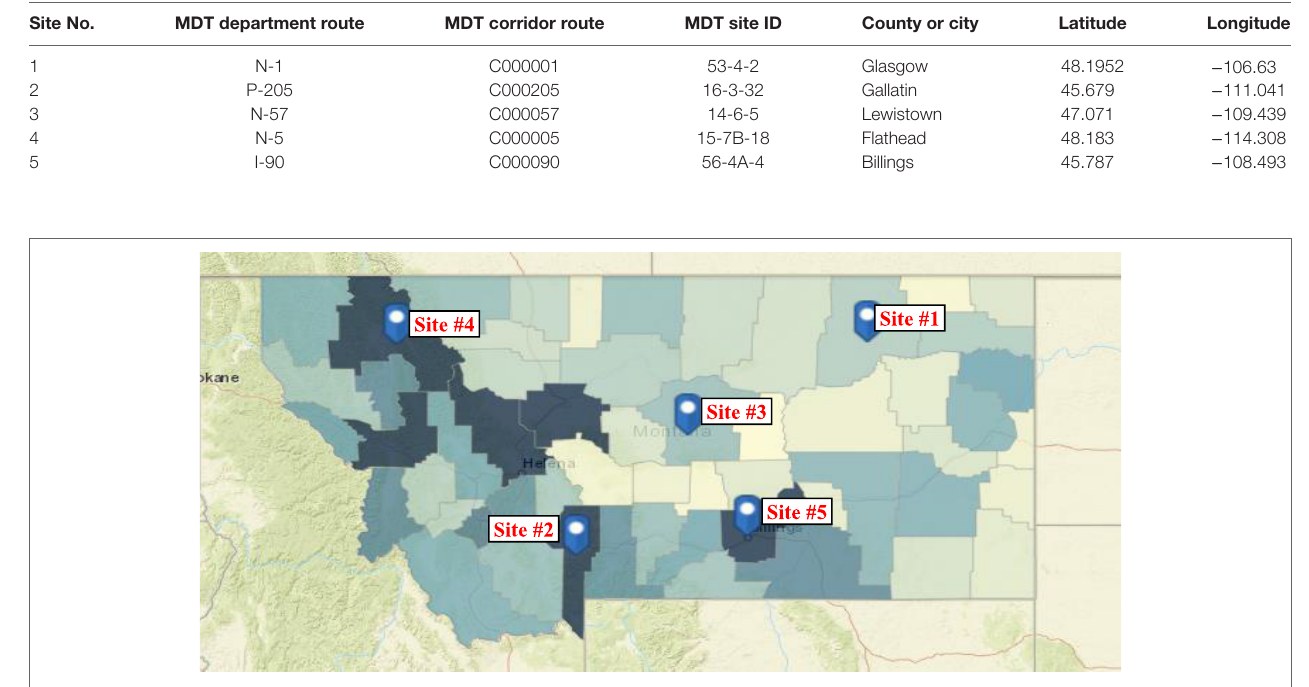
FigUre 3 | Selected sites on Montana county map.